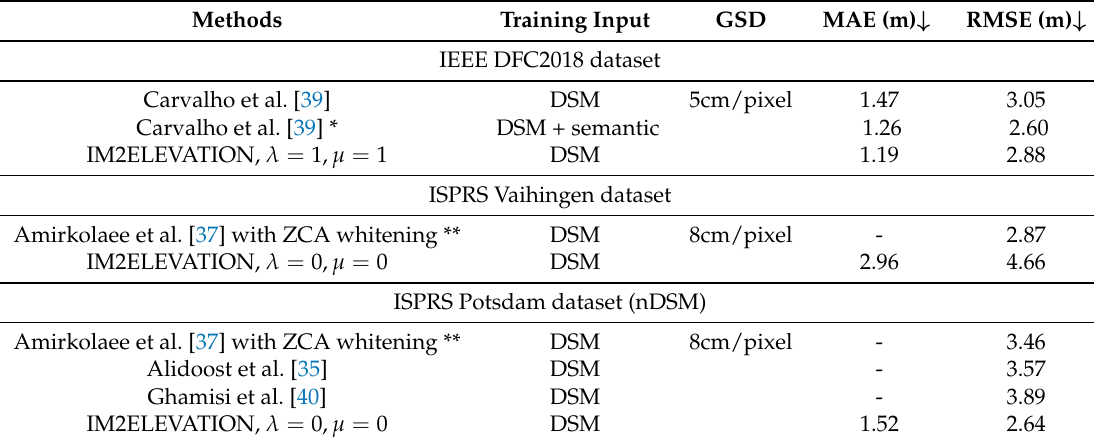
Table 4. State-of-the-art comparisons on popular datasets. Lower values of MAE and RMSE are better. * The authors of [39] perform multitask learning. ** The authors of [37] employ ZCA whitening on training data, so the results may not be comparable